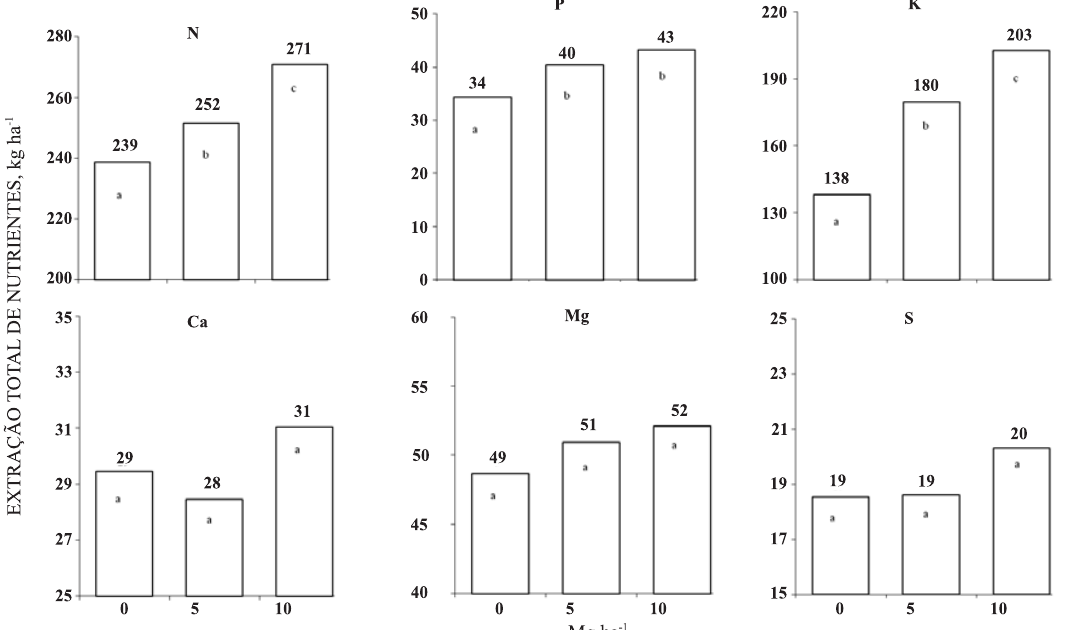
Figura 3. Extração total de N, P, K, Ca, Mg e S, em kg ha -1 , alteradas pela quantidade de palha na superfície. Comparação da média dos 13 genótipos entre os tratamentos sem e com palha na superfície, pelo teste de Tukey a 5 %. Letras minúsculas iguais nas barras verticais não diferem entre si estatisticamente. Média dos dois anos agrícolas (2001/02 e 2002/03). mineral do solo (NH 4+ e NO 3- ) pelos microrganismos Quadro 5. Extração total de nitrogênio (kg ha -1 ) em durante a decomposição do resíduo vegetal, na época função da interação quantidade de palha x de demanda de N pela planta (Sá et al., 2007; Ferreira genótipo, em um Latossolo Vermelho distrófico et al., 2009). após seis anos de plantio direto (1)